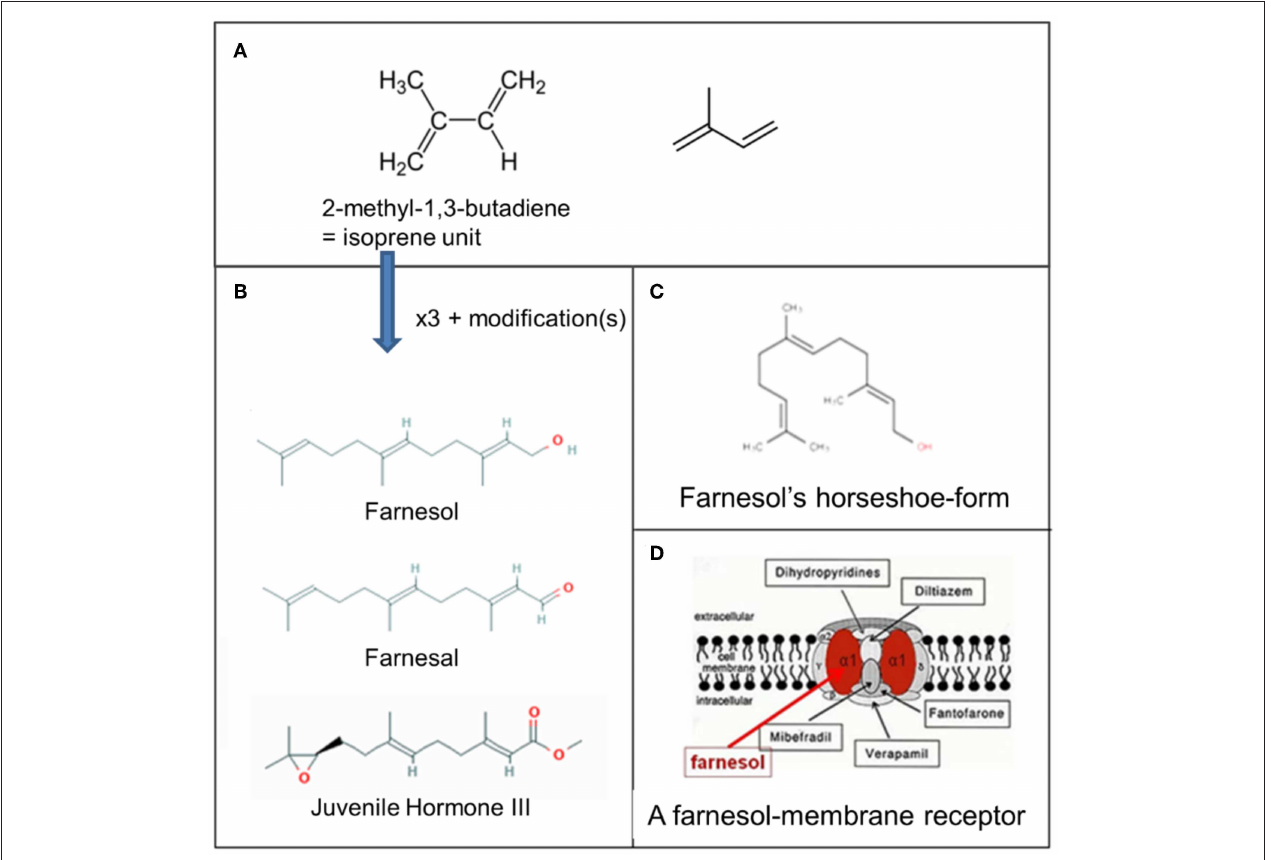
FIGURE 3 | Farnesol: some chemistry. (A) Molecular structure of 2-methyl-1,3-butadiene, the isoprene unit from which sesquiterpenoids are biosynthesized (Wikipedia: Isoprene). Three such units are needed for the synthesis of farnesol, farnesal and the juvenile hormones. (B) Farnesol, Farnesal, and JH III, one of the esters of farnesol. (C) Horseshoe-shape of farnesol. (D) Schematic representation of one of the possible membrane receptors of farnesol, namely a voltage-gated Ca 2 + -channel in the plasma membrane with its binding site for farnesol in red. Copyright: (A) From Wikipedia: Sesquiterpene (Open Access). (B) From PubChem (Open Access); (D) Ca 2 + channel (voltage gated)-adapted From Wikipedia: Calcium channel (adapted) and De Loof and Schoofs (1), Open